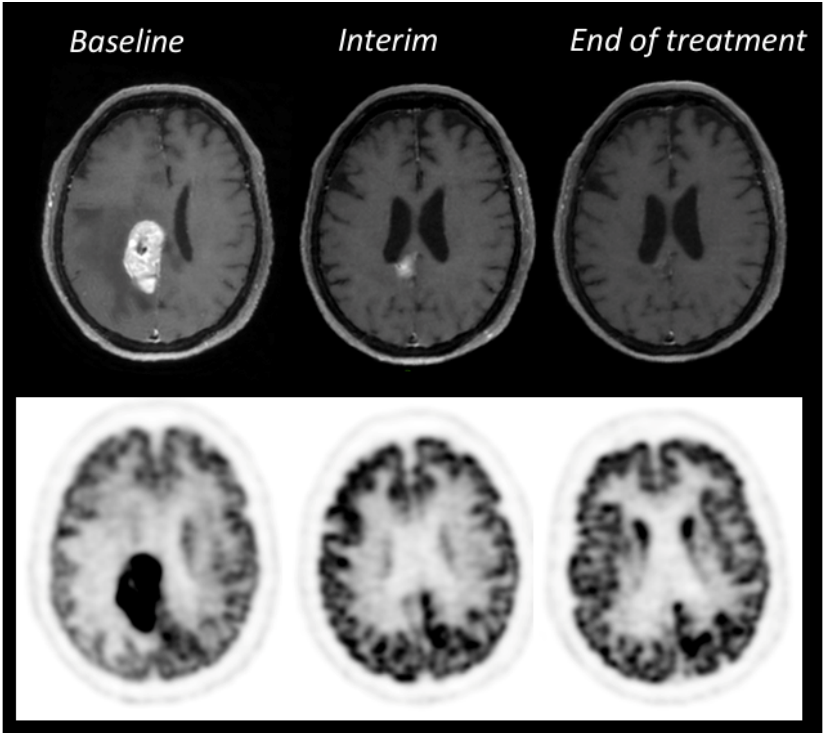
Figure 7. Therapeutic 18 F-FDG PET-MRI evaluation of PCNSL in an immunocompetent patient treated with R-MPVA chemotherapy (Rituximab, Methotrexate, Procarbazine, Vincristine, Cytarabine). Two months after the beginning of the treatment, MRI showed a partial response (81% de- crease of the enhanced MRI volume on 3DT1-gadolinium sequence) while PET was already nega- tive. Follow-up showed a complete response on both MRI and PET at the end of treatment and the patient was disease free after 3 years. This case illustrates the potential role of interim PET as an early prognostic biomarker.